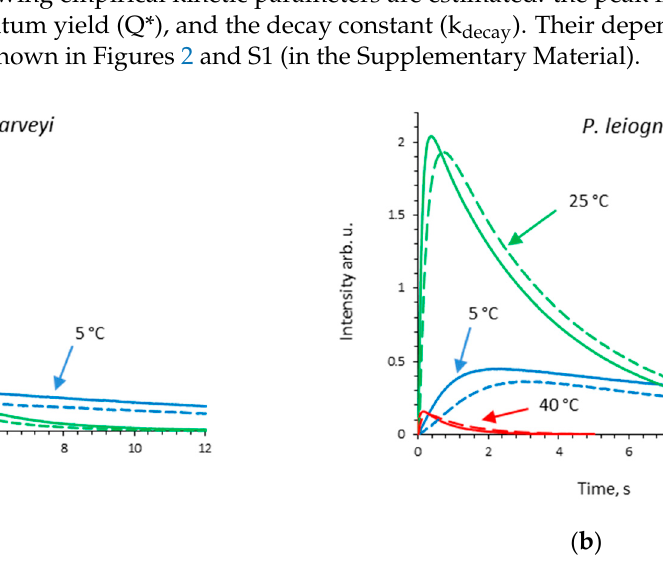
Figure 1. The kinetics of bioluminescence emission in reactions, catalyzed by luciferases from V. harveyi ( a ) and P. leiognathi ( b ) at low (5 °C, blue lines), medium (25 °C, green lines) and high (40 °C, red lines) temperature in the buffer (solid lines) and in sucrose solution (dashed lines). Concentrations in the reaction mixture were: luciferase—0.5 µM, flavin—15 µM, decanal—50 µM.